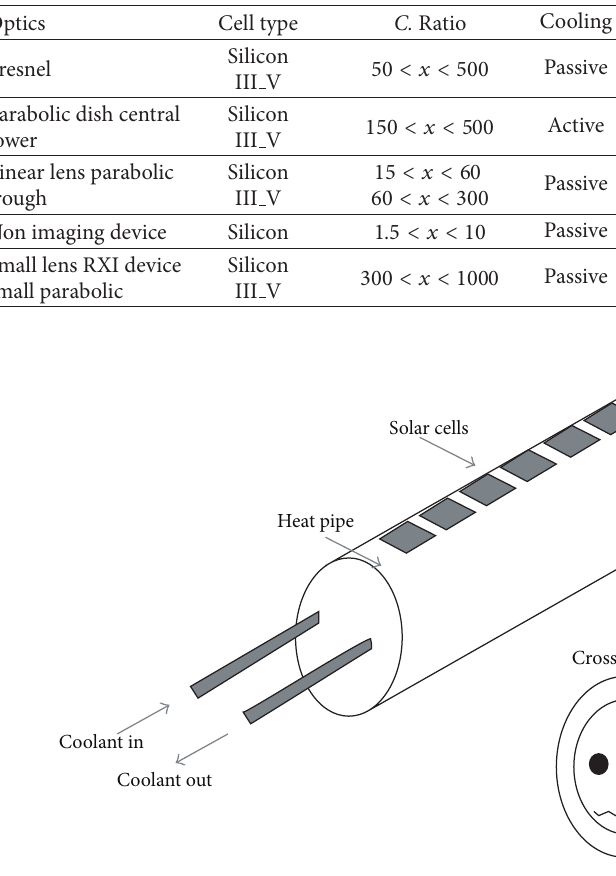
Table 4: Description of CPV modules.